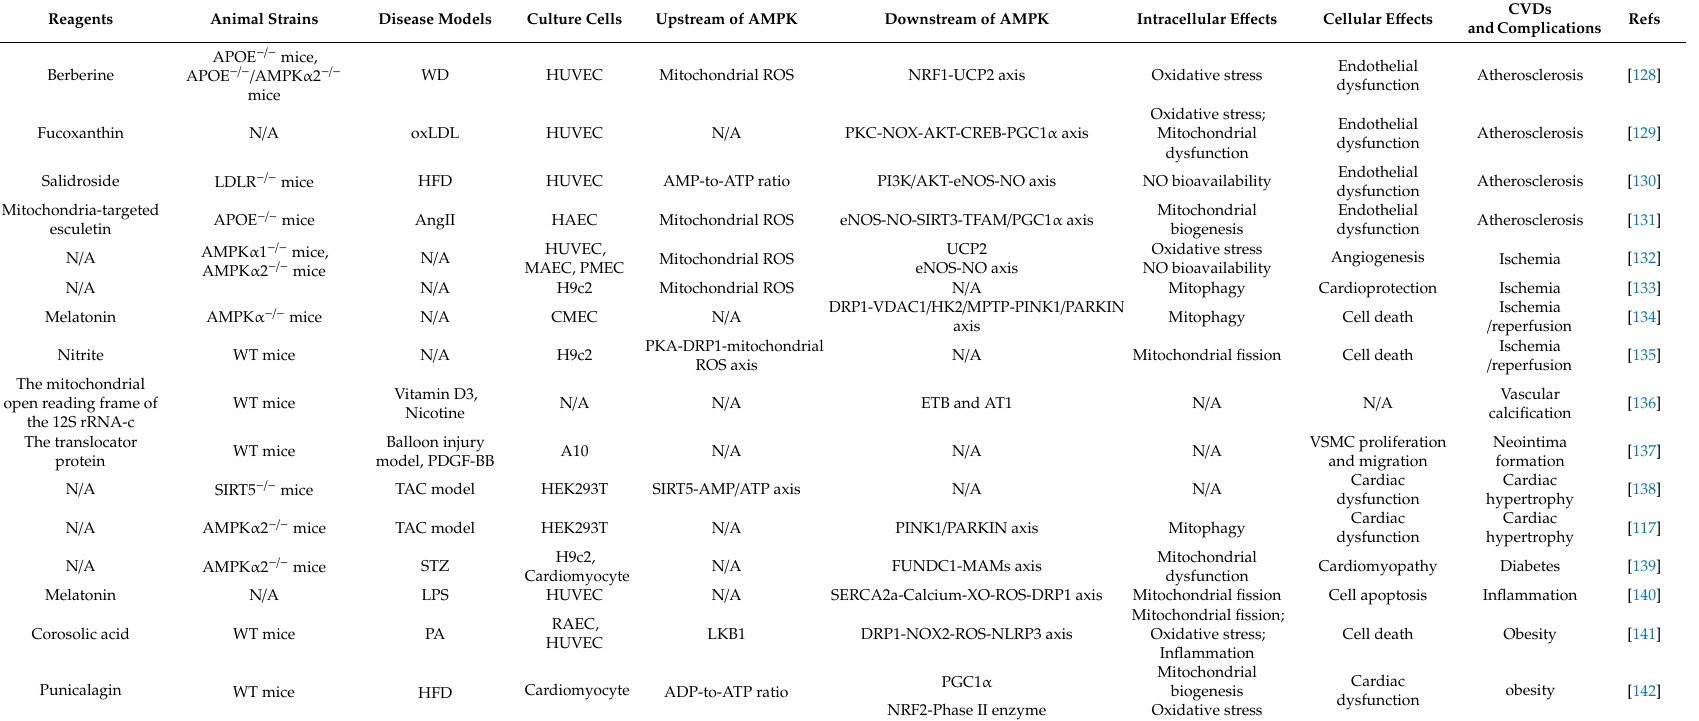
Table 3. AMPK, mitochondrial, cardiovascular diseases (CVDs), and complications. SIRT, sirtuin; APOE, apolipoprotein E; LDL, low-density lipoprotein; HFD, high-fat diet; PA, palmitate; TAC, transverse aortic constriction; DRP1, dynamin-like protein; PINK1, phosphatase and tensin homolog-induced putative kinase 1; FUNDC1, FUN14 domain containing 1; ETB, endothelin B; MAM, mitochondria-associated endoplasmic reticulum